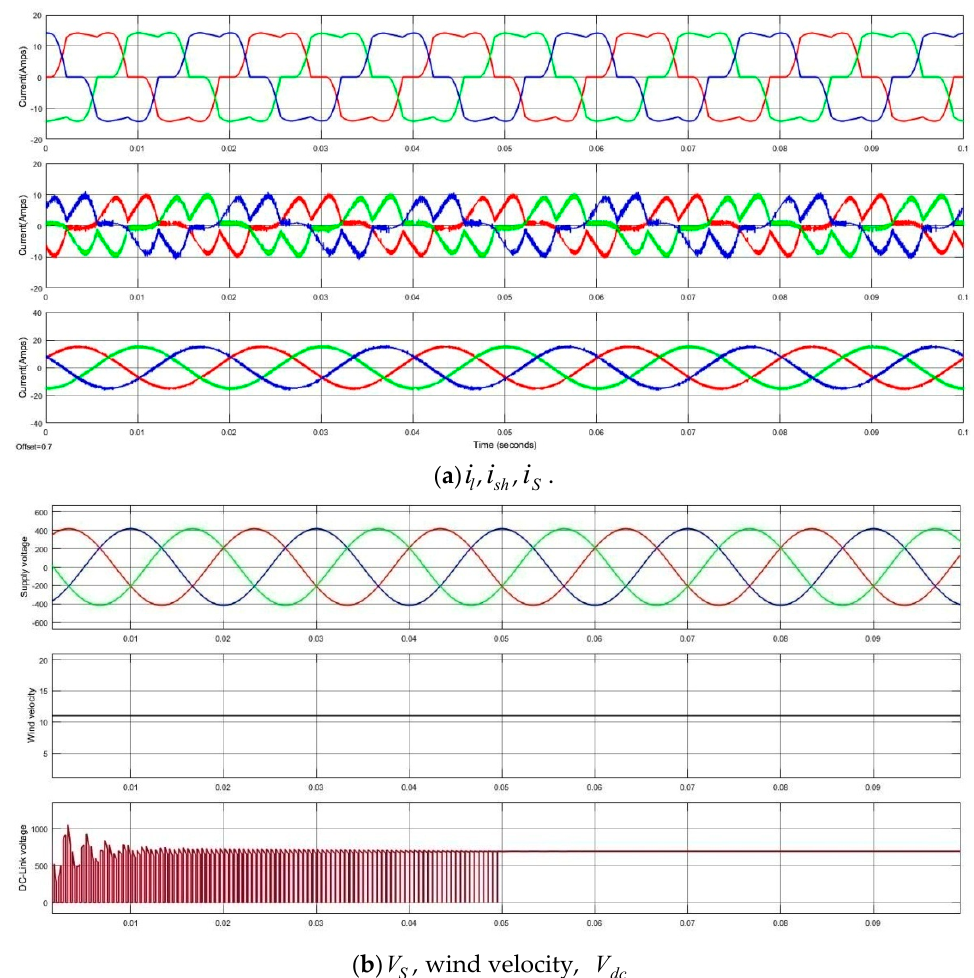
The waveforms during steady-state conditions of the proposed SH-WPBS test system for all cases 1–5 are shown in Figures 15–19.